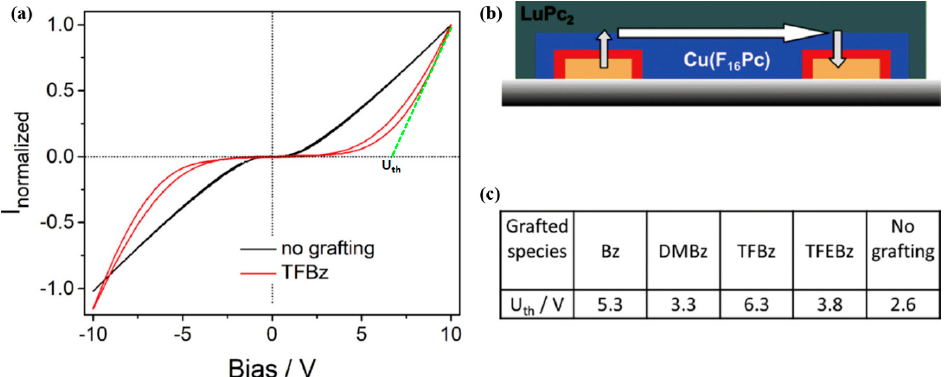
Figure 7. Normalized I(V) curves of a Cu(F 16 Pc)/LuPc 2 bilayer deposited on electrografted ITO (red) and on unmodified ITO (black) ( a ). Scheme of the device configuration ( b ) and table depicting the apparent energy barrier of the device obtained for electrografting of benzene (Bz), dimethoxy-benzene (DMBz), tetrafluoro-benzene (TFBz) and Trifluoroethoxy benezene (TFEBz) ( c ) [14].